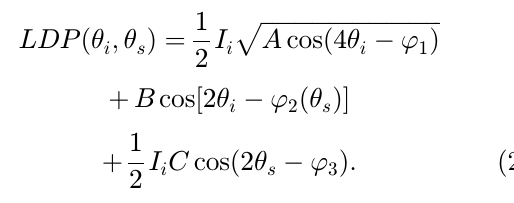
ffiffiffiffiffiffiffiffiffiffiffiffiffiffiffiffiffiffiffiffiffiffiffiffiffiffiffiffiffiffiffiffi A cos ð 4 (cid:1)